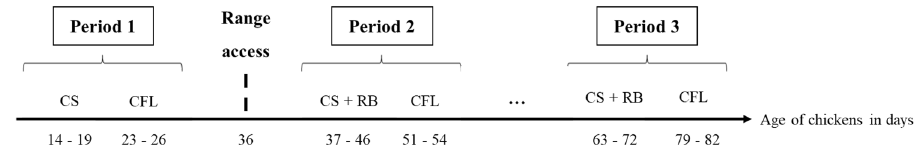
Figure 1. Schedule of the behavioral observations (Continuous sampling, CS, n = 58), Ranging behavior measurements (RB, n = 117), and contrafreeloading tests (CFL, n = 58) made during the production cycle of free- range chickens.